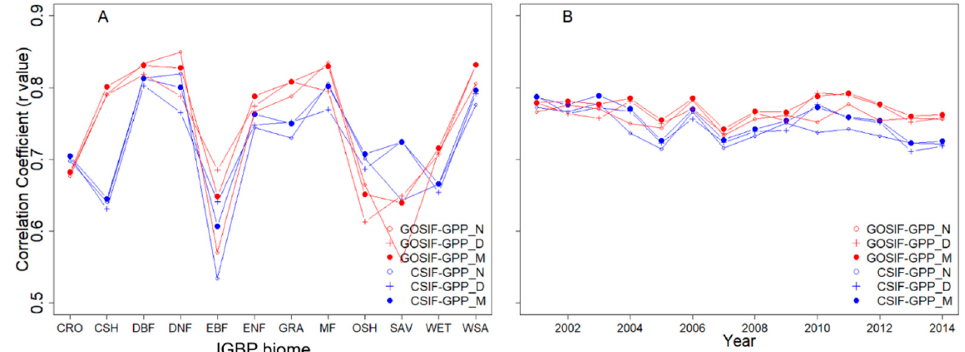
Figure 2. Pearson correlation coefficients (r value) between SIFc (CSIF and GOSIF) and GPP from two partitioning methods (GPP_D and GPP_N) and the mean of them (GPP_M) across ( A ) all 12 biomes (daily data at specific biome of all the years) and ( B ) all 14 years (daily data from whole year) ( p < 0.001). Biomes are: croplands (CRO), closed shrublands (CSH), deciduous broadleaf forest (DBF), deciduous needleleaf forest (DNF), evergreen broadleaf forest (EBF), evergreen needleleaf forest (ENF), grasslands (GRA), mixed forests (MF), open shrublands (OSH), savannas (SAV), per- manent wetlands (WET), and woody savannas (WSA). Years are from 2001 to 2014.